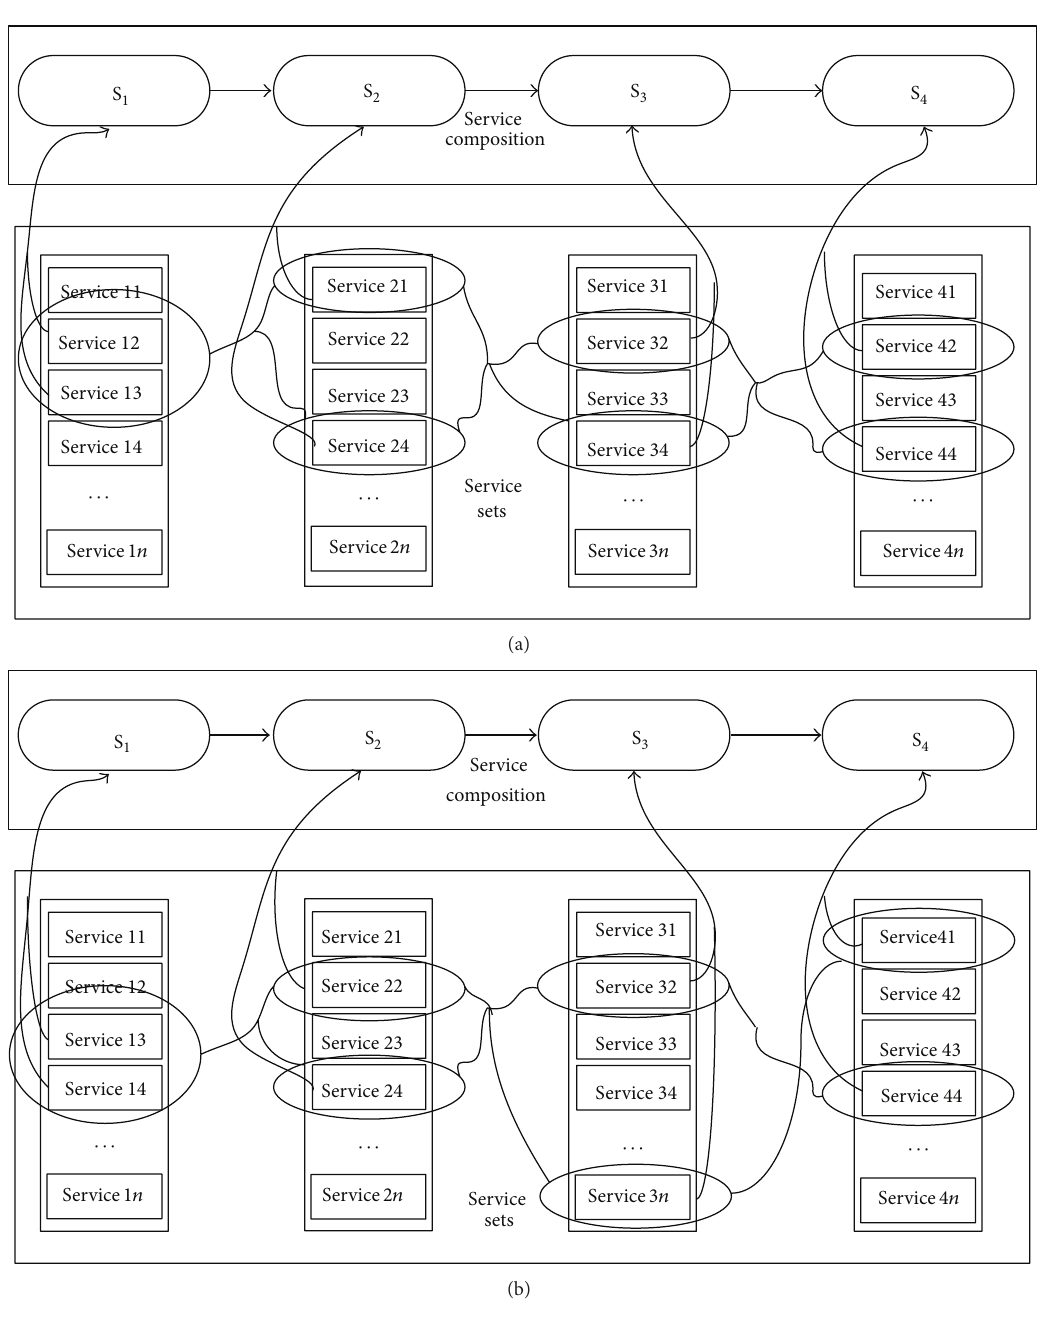
Figure 5: (a) The first path for multiple service parallel allocation. (b) The second path for multiple service parallel allocation.